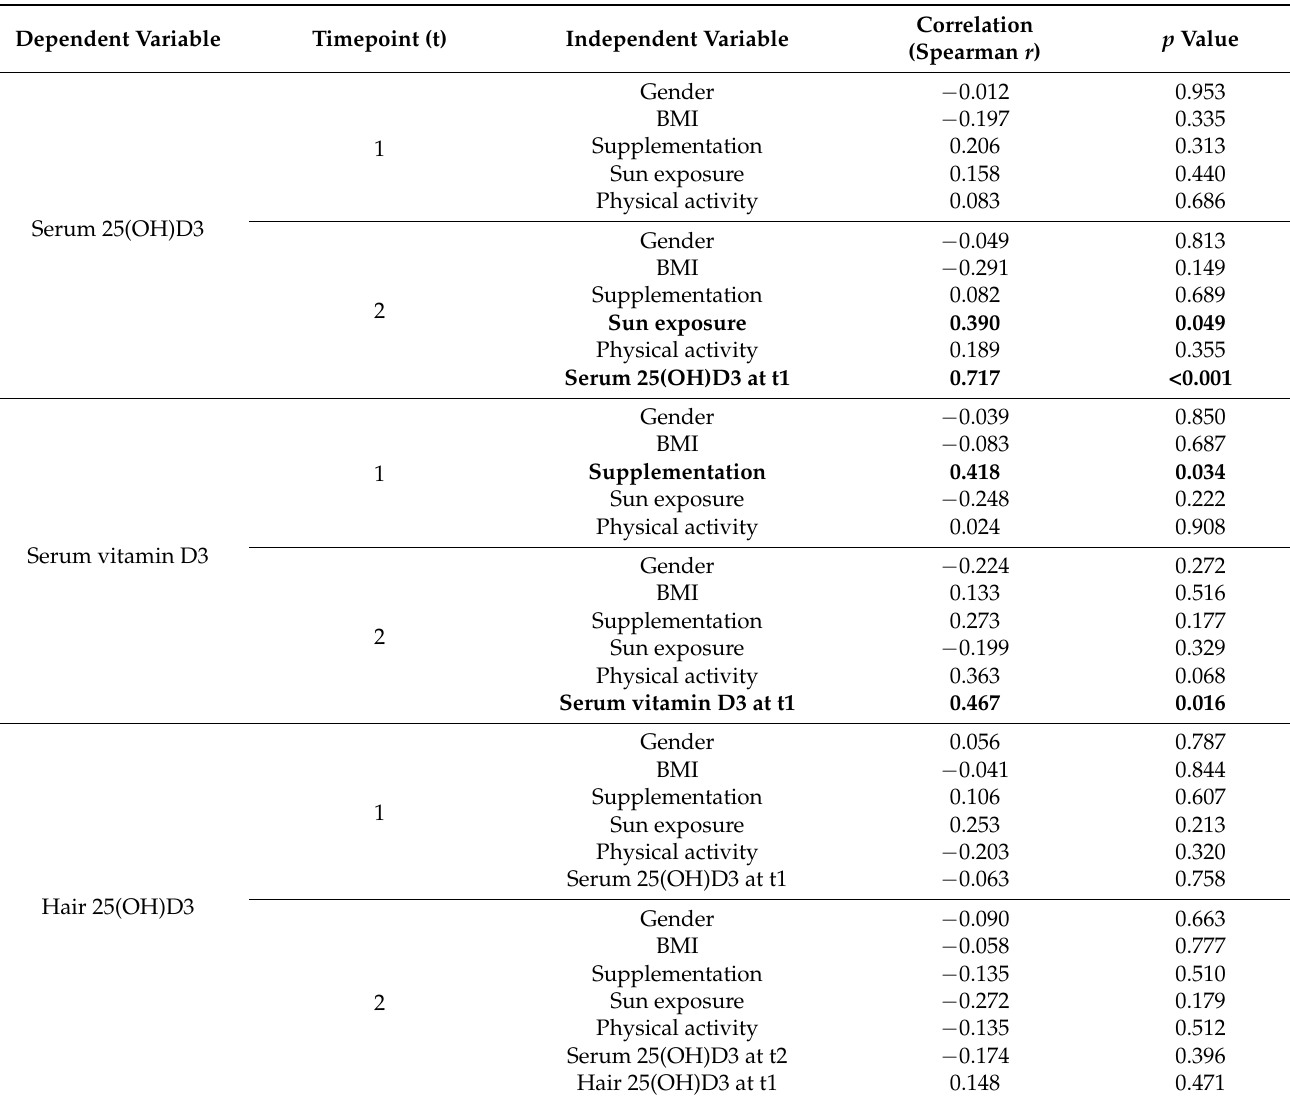
Table 3. Correlation between demographical data and the serum and hair concentrations of